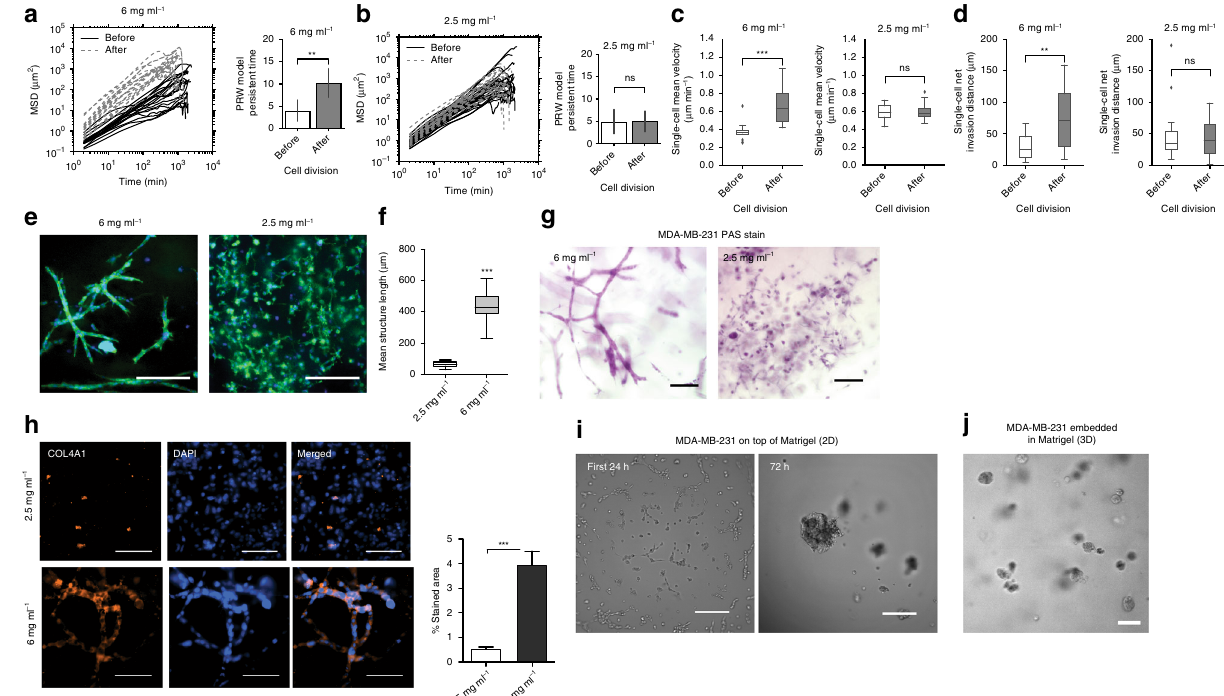
Fig. 1 High-density 3D collagen microenvironment promotes a switch to persistent cell migration in cancer cells. a Mean squared displacement (MSD) and persistent time of MDA-MB-231 cells before and after cell division in high-density collagen. The persistent time was calculated from the MSDs using the persistent random walk model (see “ Methods ” ). MSDs are shown for 12 representative cell trajectories. b Mean MSD and persistent time of MDA-MB-231 cells before and after cell division in low-density collagen. The persistent time was calculated from the MSDs using the persistent random walk model (see “ Methods ” ). MSDs are shown for 12 representative cell trajectories. c Single-cell velocity measured at 2 min intervals before and after cell division. d Single-cell net invasion distance before and after cell division for cells in high-density and low-density collagen. e Representative image of MDA-MB-231 cells cultured in a 6 mg ml − 1 (left) and in a 2.5 mg ml − 1 (right) collagen I matrix after 7 days of culture. Cells are stained with Alexa-488 Phalloidin (F-Actin) and DAPI (nuclei). Scale bar 250 μ m. f Quanti fi cation of mean structure length in low-density and high-density collagen, from images acquired in three independent experiments. g PAS stain of MDA-MB-231 cells cultured for 7 days in a 3D collagen gel of high-density (left) and low-density (right). Scale bar 100 µ m. h Immuno fl uorescence staining of MDA-MB-231 cells for collagen IV after 7 days of culture in 6 vs. 2.5 mg ml − 1 . Representative images of n = 2 biological replicates. Bar graph shows mean and s.e.m. of quanti fi cation of stained area performed in 15 different fi elds of view. Scale bar 100 μ m. i MDA- MB-231 cells cultured on top of growth factor-reduced matrigel after 24 h (left) and after 72 hours (right). Scale bar 250 μ m. j MDA-MB-231 cells cultured inside growth factor-reduced matrigel in 3D culture for 7 days. Scale bar 100 μ m. Box plots show quartiles of the dataset with whiskers extending to fi rst and third quartiles. n = 3 biological replicates for all experiments unless otherwise noted. Statistical signi fi cance was determined by Mann – Whitney U test and is indicated as *, **, *** for p ≤ 0.05, p ≤ 0.01, p ≤ 0.001,